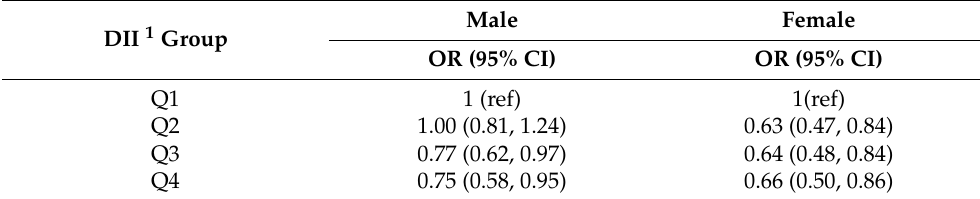
Table 3. Odds ratios (ORs) and 95% confidence intervals for hyperuricemia and DII scores stratified by gender. DII 1 Group